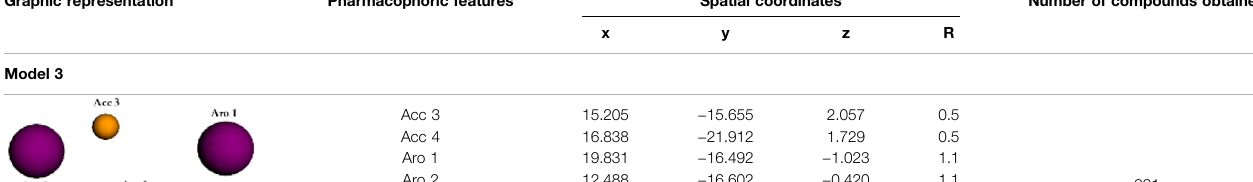
TABLE 7 | Pharmacophore Models 3, 4, 5, 6, 7, and corresponding graphic representations, pharmacophoric features, spatial coordinates and number of compounds retrieved in each virtual screening campaign using Molport database. Graphic